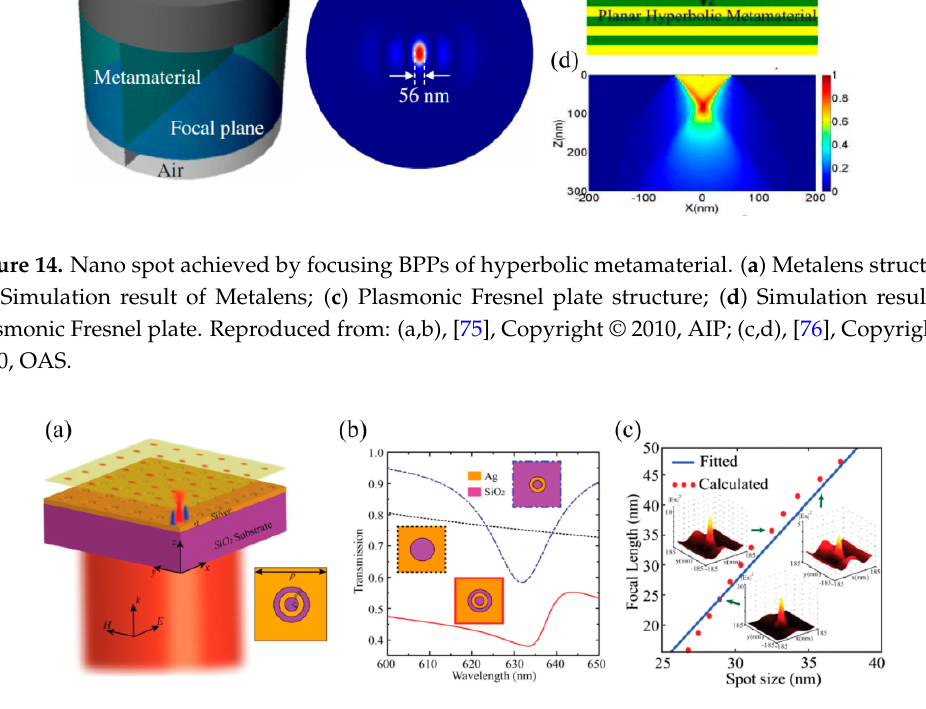
Figure 15. Nano focusing by plasmonic Fano resonance lens. ( a ) Schematic structure view; ( b ) transmission spectra; ( c ) nano focus length with variant focus size. Reproduced from [78], Copyright © 2016, RSC.